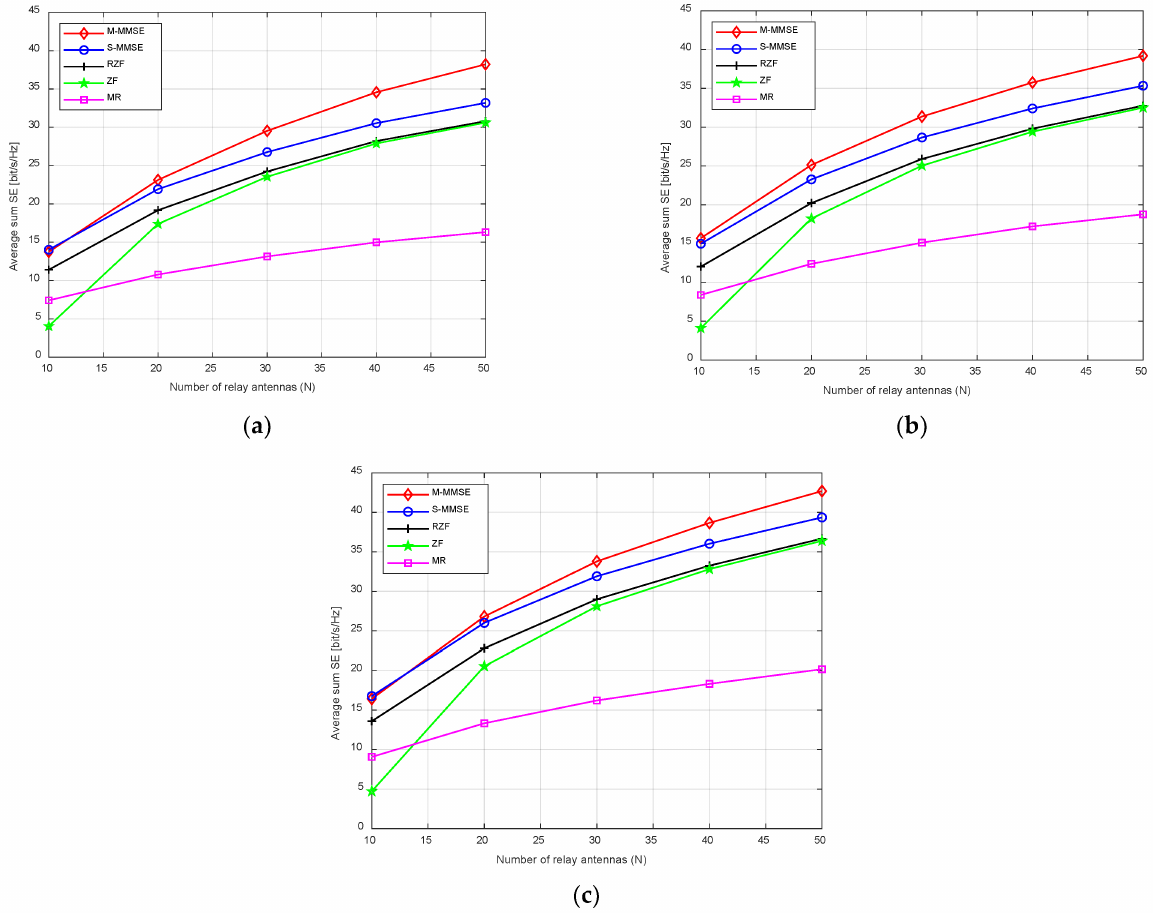
Figure 7. Average sum SE as a function of the number of relay antennas for different combining